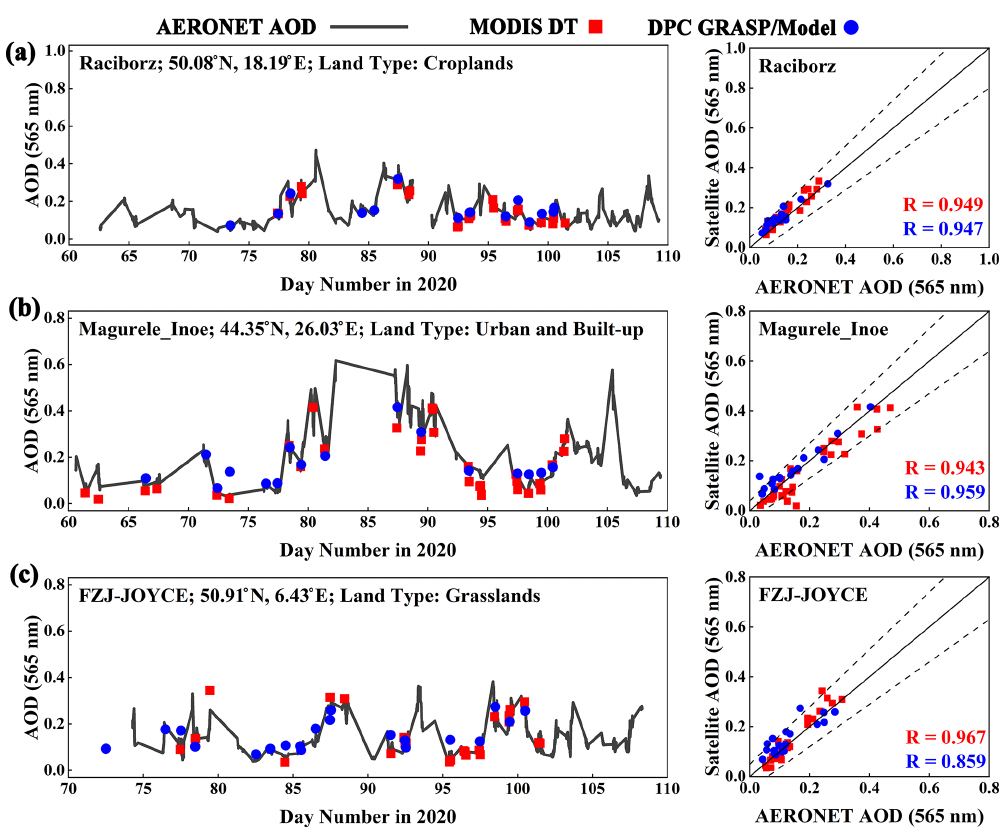
Figure 9. Time series of AOD from the DPC GRASP/Model scheme versus the MODIS DT products and AERONET observations at three sites, i.e. (a) Raciborz, (b) Magurele_Inoe, and (c) FZJ-JOYCE. The scatterplot shows the relationship between AERONET AOD and satellite